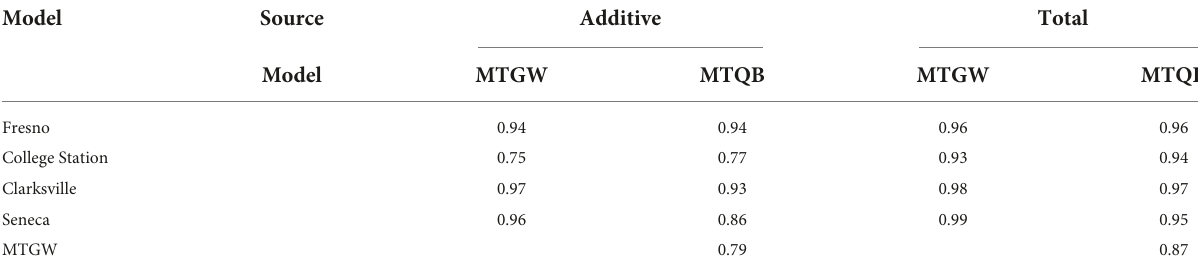
TABLE 2 Estimated model parameters (vAW, additive whole-genome variance; vAQ, additive QTL variance; vAB, additive background-genome variance; vDW, dominance whole-genome variance; vGW, total whole-genome variance; vU, within trial permanent among tree variance; vR, within trial tree-by-season residual variance; vP, phenotypic variance; h2, narrow sense heritability; H2, broad sense heritability) for most parsimonious single-trial genome-wide (STGW); multi-trial genome-wide (MTGW), or QTL + background (MTQB) multivariate models for SSC assessed on 577 peach/nectarine individuals across 10 trial-by-season environments.